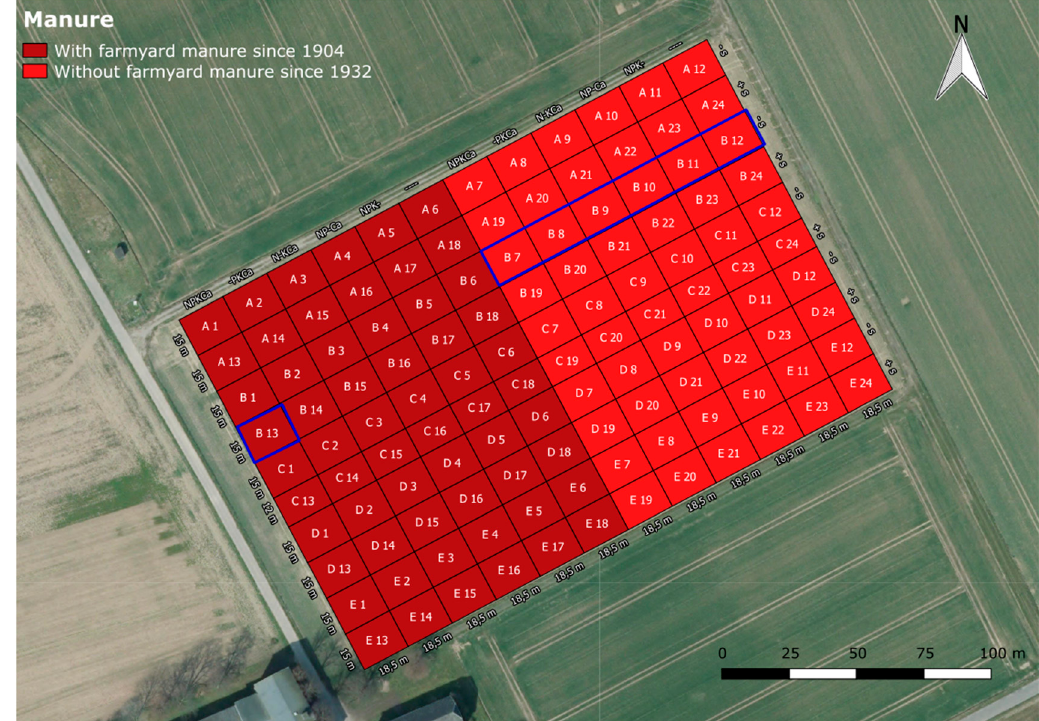
Figure 1. Experimental setup of the long-term fertilizer experiment Dikopshof, Germany after 1953 (strips A to E). In the current study, the considered plots are plots B7 to B13 in strip B (marked in blue).